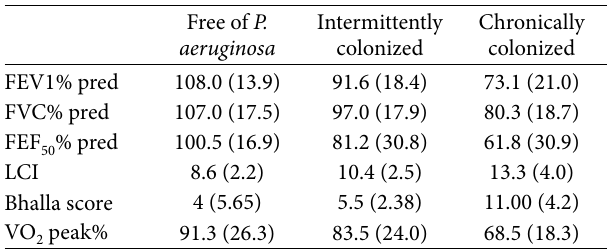
Table 2: Spirometric, MBW, CPET and Bhalla score values in the 3 patient groups (values are shown as mean